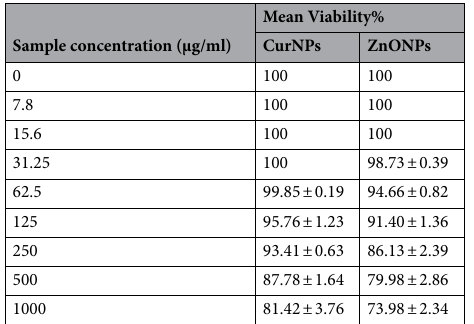
Sample concentration (µg/ml)